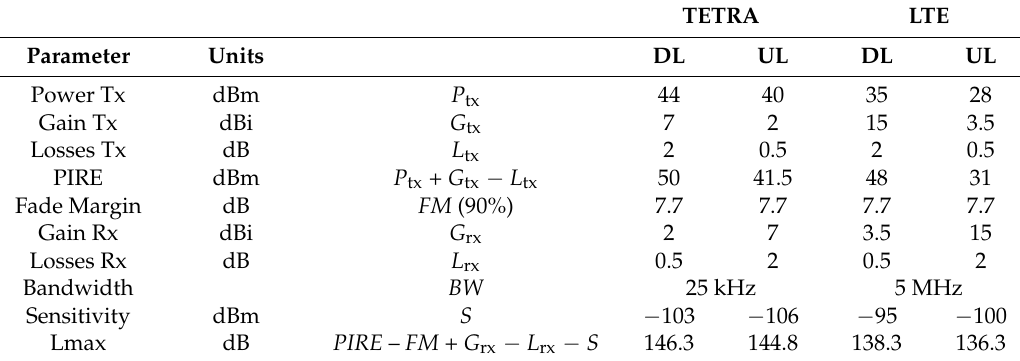
Table 3. Link budget for the TETRA and LTE